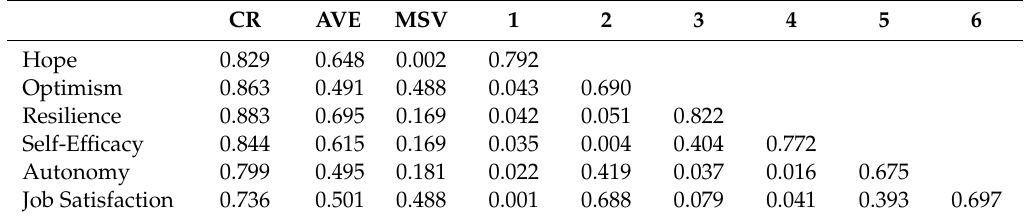
Table 11. Model fit